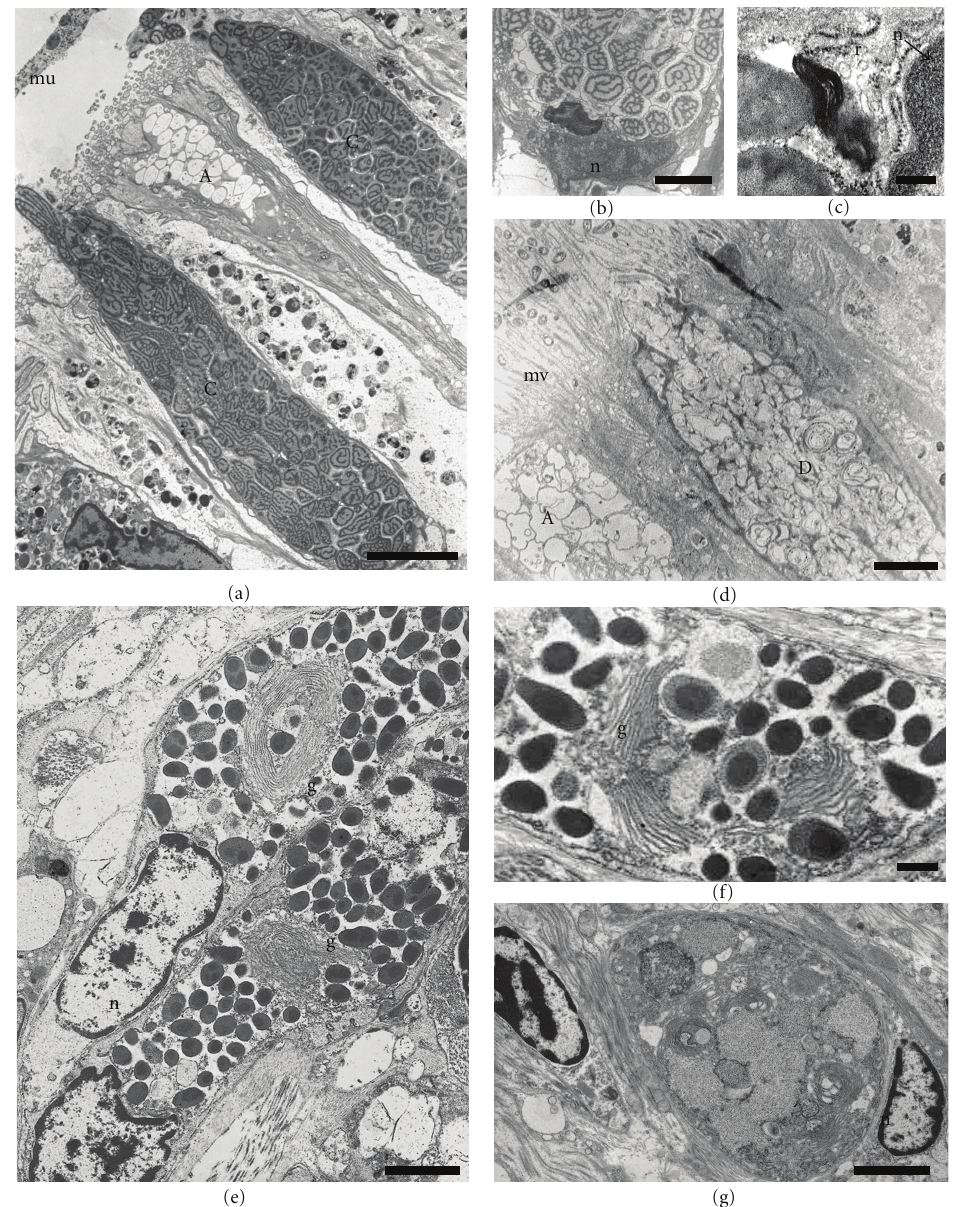
Figure 5: Transmission electron microphotographs of di ff erent types of side secretory cells (a–d) and subepithelial glands (e–g). (a) The characteristic secretory granules of the type C remain outside the cell, forming the mucus (mu). Type A with partially secreted granules can be observed. Bar: 5 µ m. (b) Basal region of the type C cell showing a body with tightly packed membranes below the nucleus (n) Bar: 2 µ m. (c) Detail of latter microphotograph showing a prominent rough endoplasmic reticulum (r) between nucleus (n) and the body. Bar: 0.2 µ m. (d) A Type D cell with swirled membranous vesicles and a type A cell. Bar: 3 µ m. (e) Subepithelial multicellular gland with a well-developed Golgi complex (g) and dense secretory granules associated. Bar: 2 µ m. F. Detail of the Golgi complex (g) in the subepithelial multicellular gland. Bar. 0.5 µ m. (g) Subepithelial unicellular gland. Bar: 2 µ